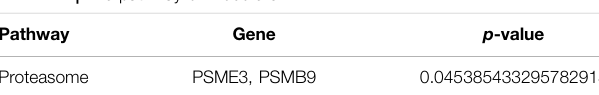
TABLE 4 | The pathway of module 3.